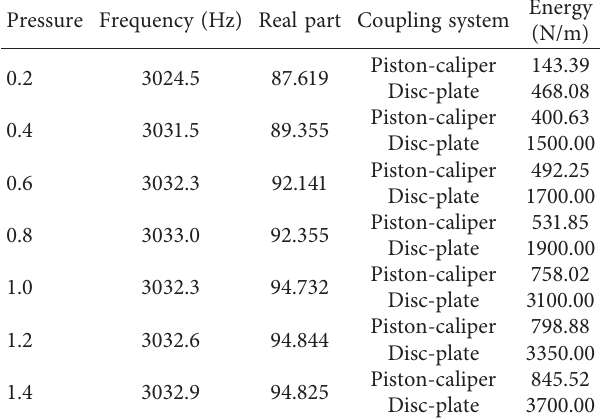
Table 4: Feed-in energy of the dual coupling subsystem near